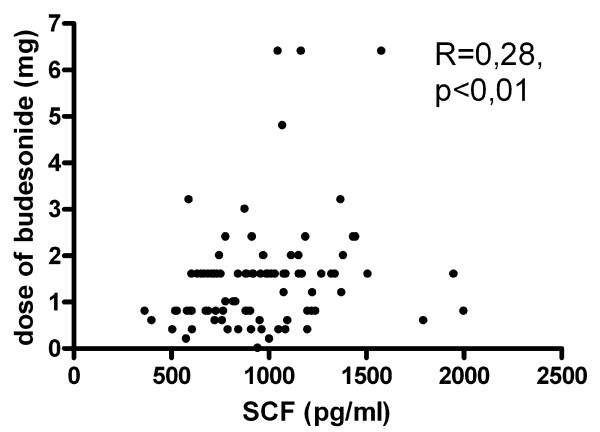
Correlation between SCF serum concentrations and dose of inhaled steroids taken by the patients (n = 88).